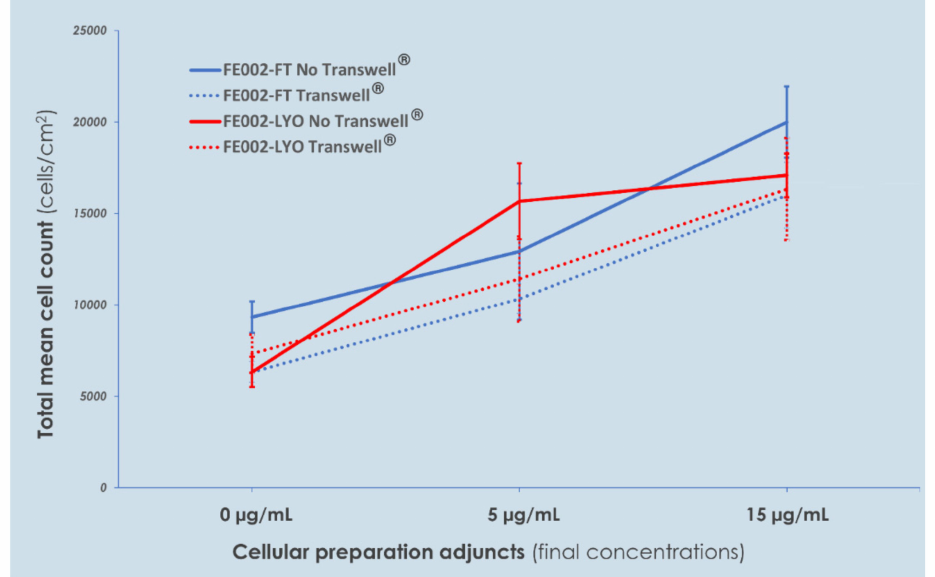
Figure 8. Adult primary fibroblast cell proliferation stimulation potential of various doses (i.e., expressed in normalized total protein contents at the final dilution in the culture medium) of dermal FPC (e.g., FE002-SK2 cell type) lysates (i.e., “FT” for freeze-thaw) and lyophilizates (i.e., “LYO”, for- mula I), respectively. The culture medium contained 10% v / v FBS. Cell enumeration was performed 96 h following treatment with the test-items. No statistically significant differences were found across the different groups, for each specific timepoint. FBS, fetal bovine serum; FPC, fibroblast progenitor cells; FT, freeze-thaw; LYO,